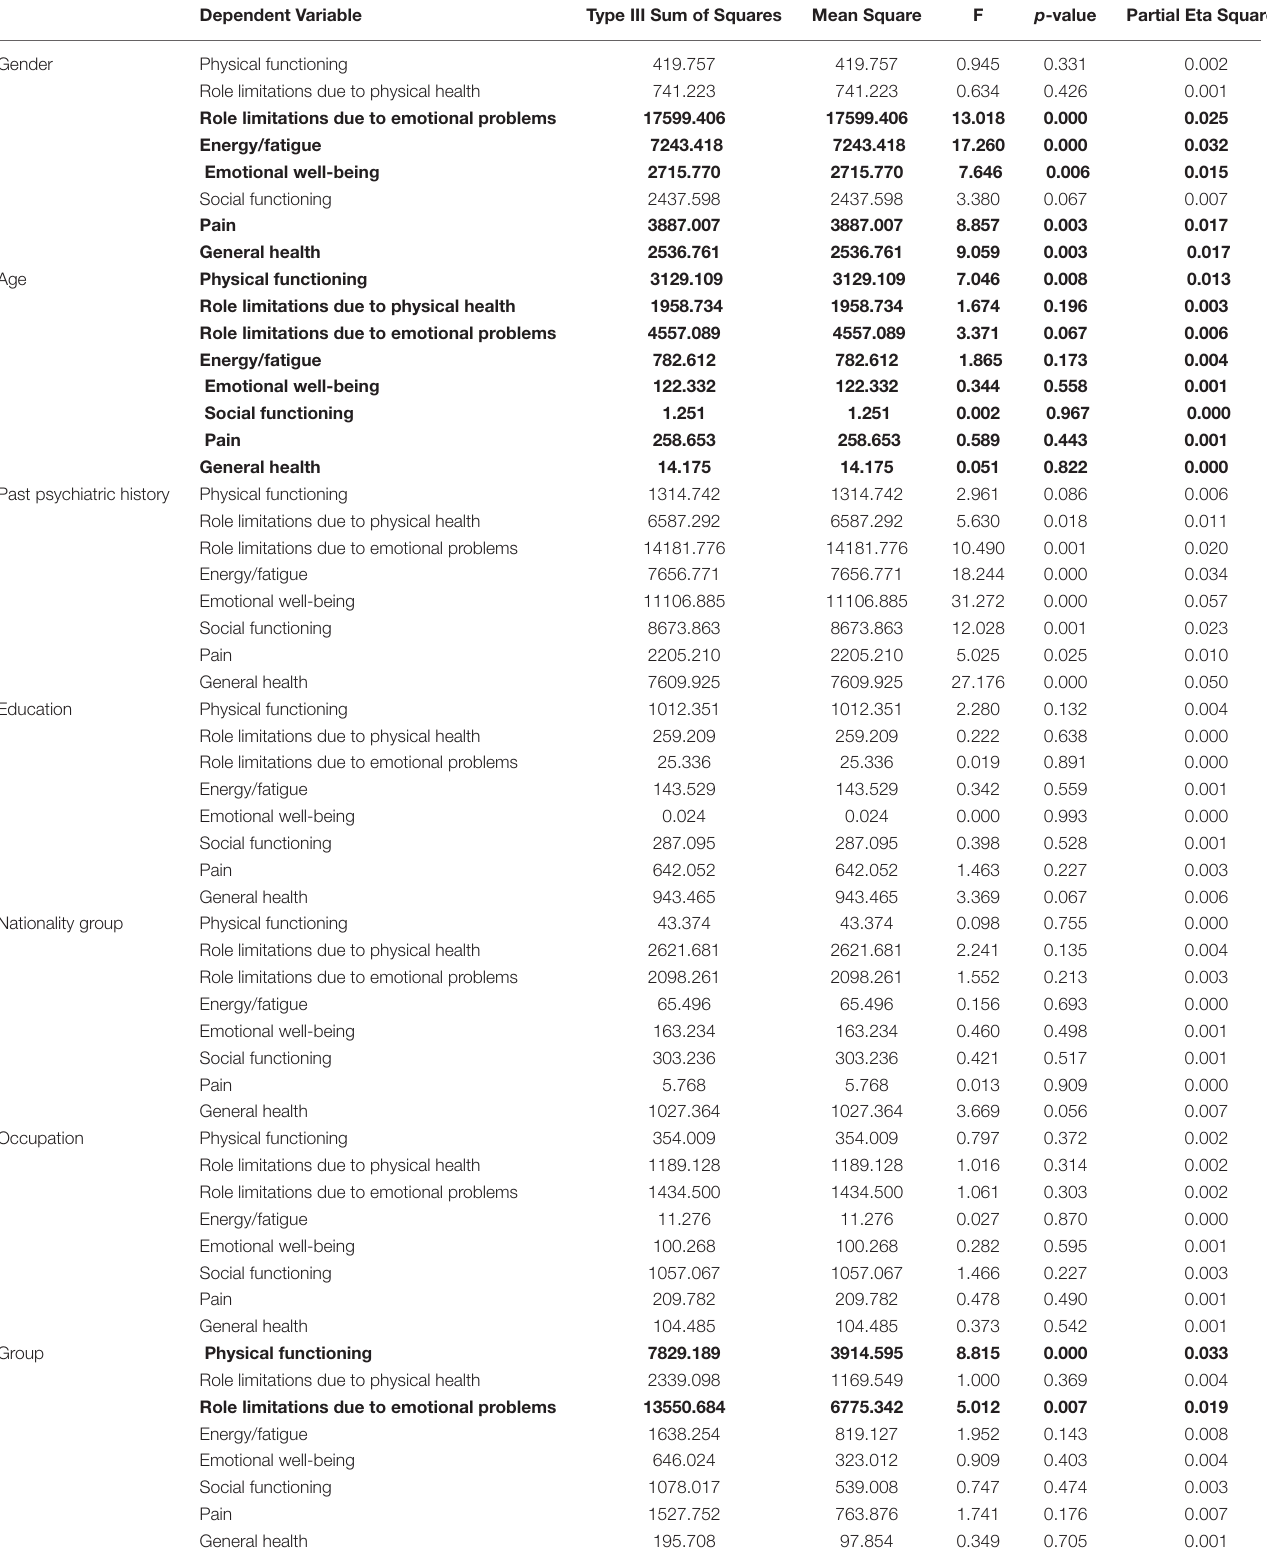
TABLE 4 | Univariate tests of between-subject’s effects with SF-36 scale scores as dependent variables, group (inpatients vs. COVID-19 infected quarantined individuals vs. controls) as a fixed factor, and sociodemographic and clinical characteristics as